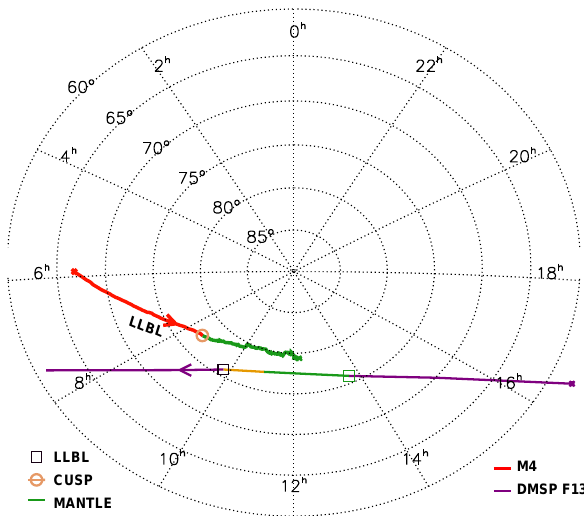
Fig. 6. Footprints of the MAGION-4 and DMSP F13 orbits. The crossed regions are labeled with different symbols and